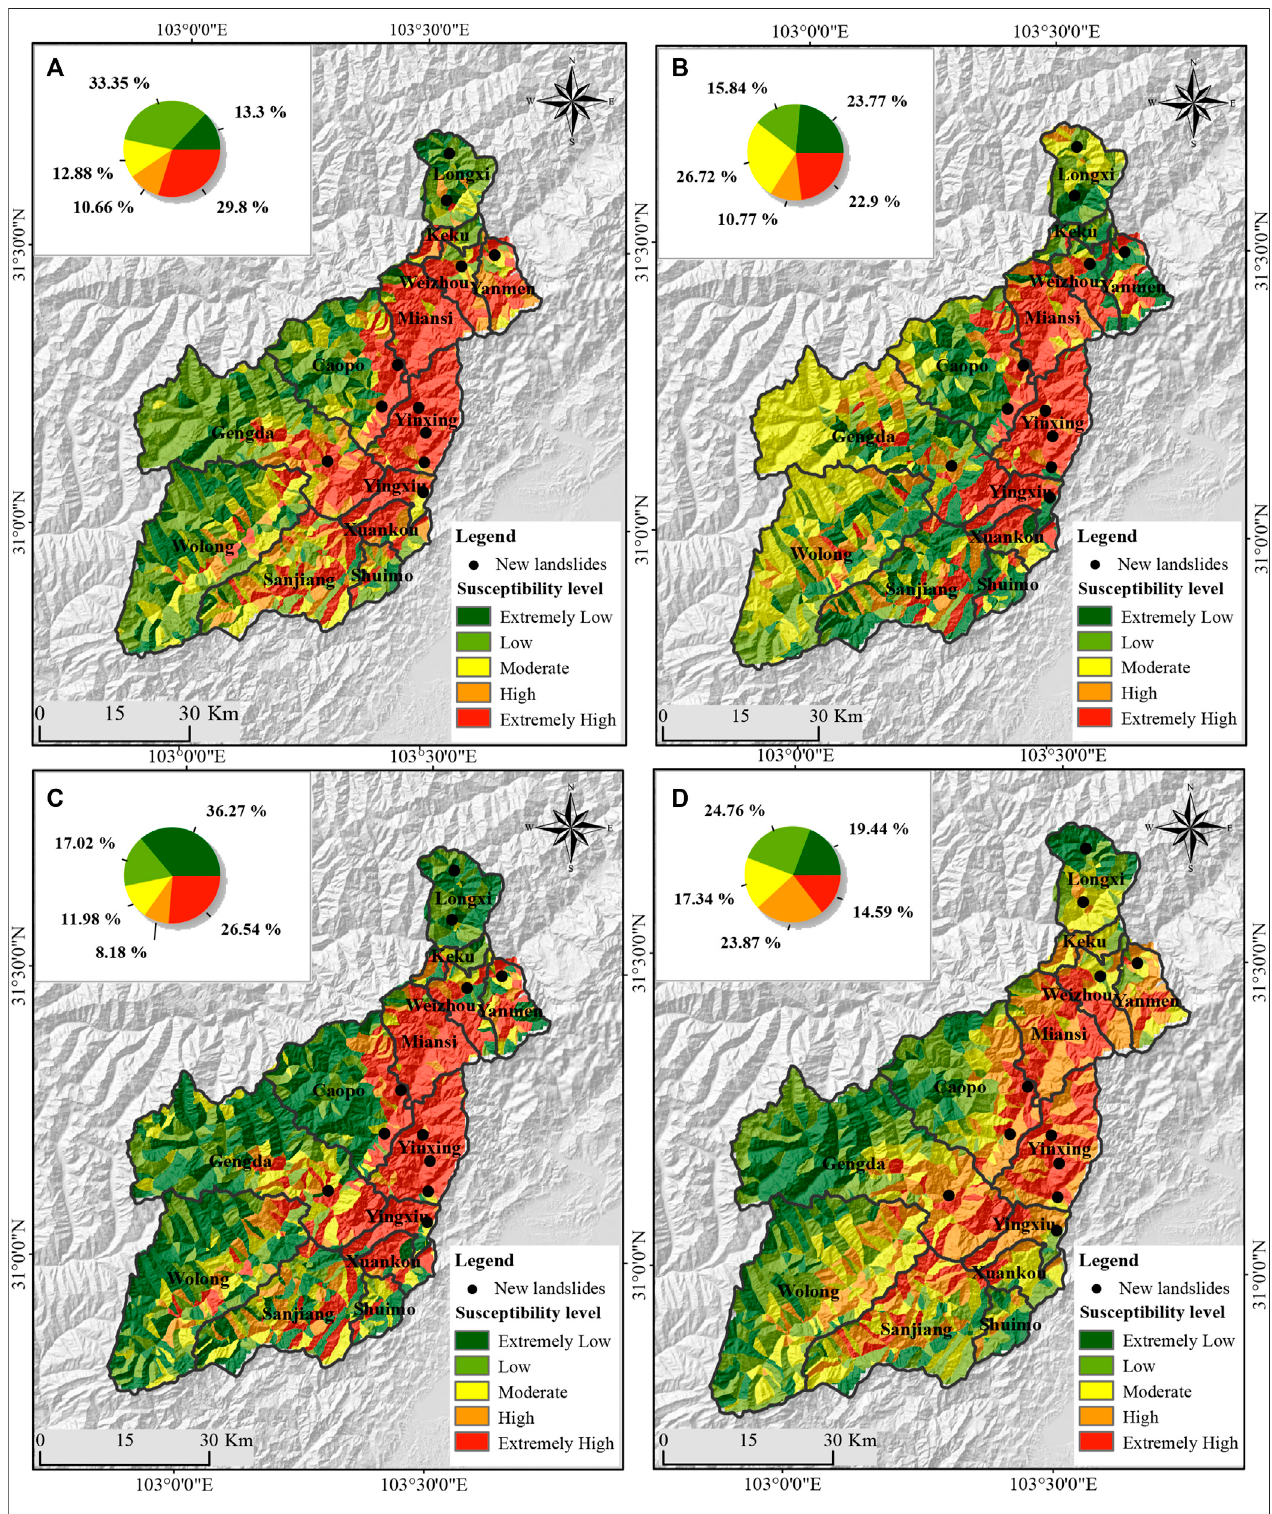
FIGURE 7 | Landslide susceptibility map obtained based on the SVM using different negative data: (A) T c , (B) T p , (C) T i , and (D) . T OCSVM